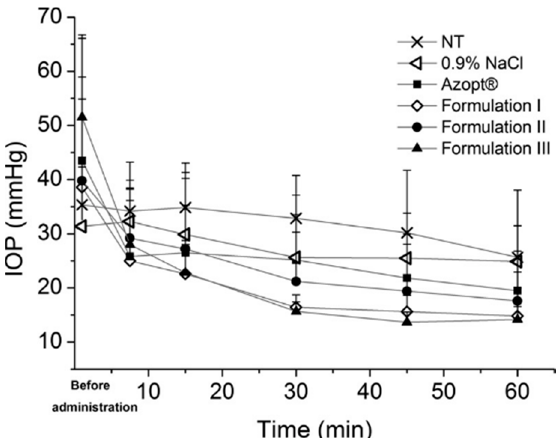
Figure 3. The intraocular pressure (IOP) values as a function of time after topical application of brinzolamide nanocrystal Formulations I–III, Azopt, 0.9% NaCl and the non-treated group (NT). Nanocrystal Formulation III was most efficient in reducing the intraocular pressure (reprinted from [21] with permission. Copyright Elsevier 2014).